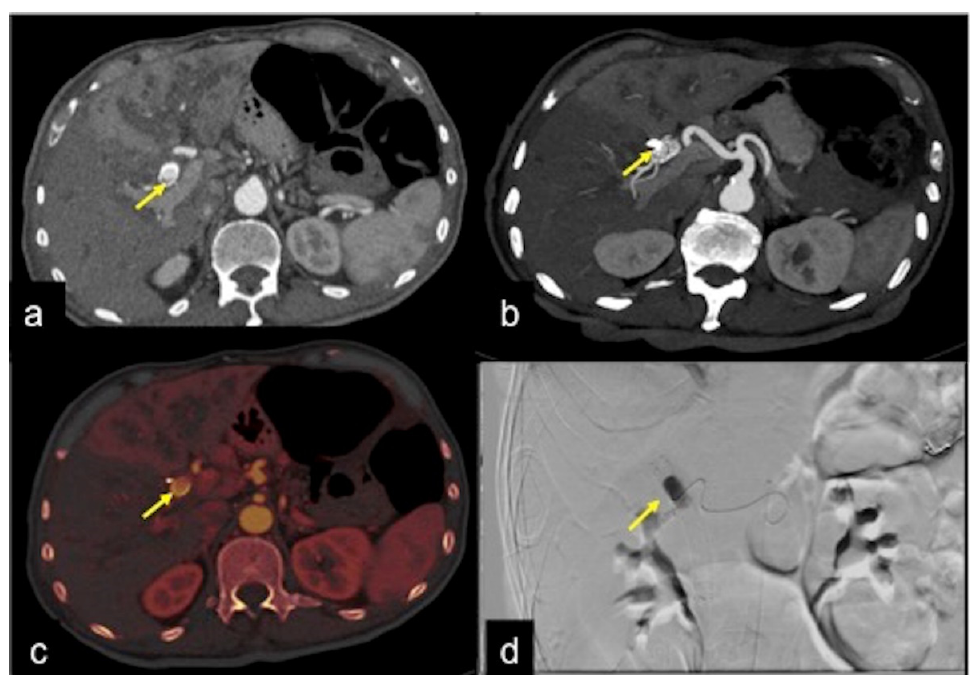
Figure 32. DECTA study of iatrogenic embolism. On arterial phase ( a ) with MIP reconstruction ( b ) and relative iodinated map ( c ) a pseudoaneurysm in the lumen of the biliary stent is detected (( a – c ) arrow). The angiography ( d ) identifies the pseudoaneurysm for exclusion treatment